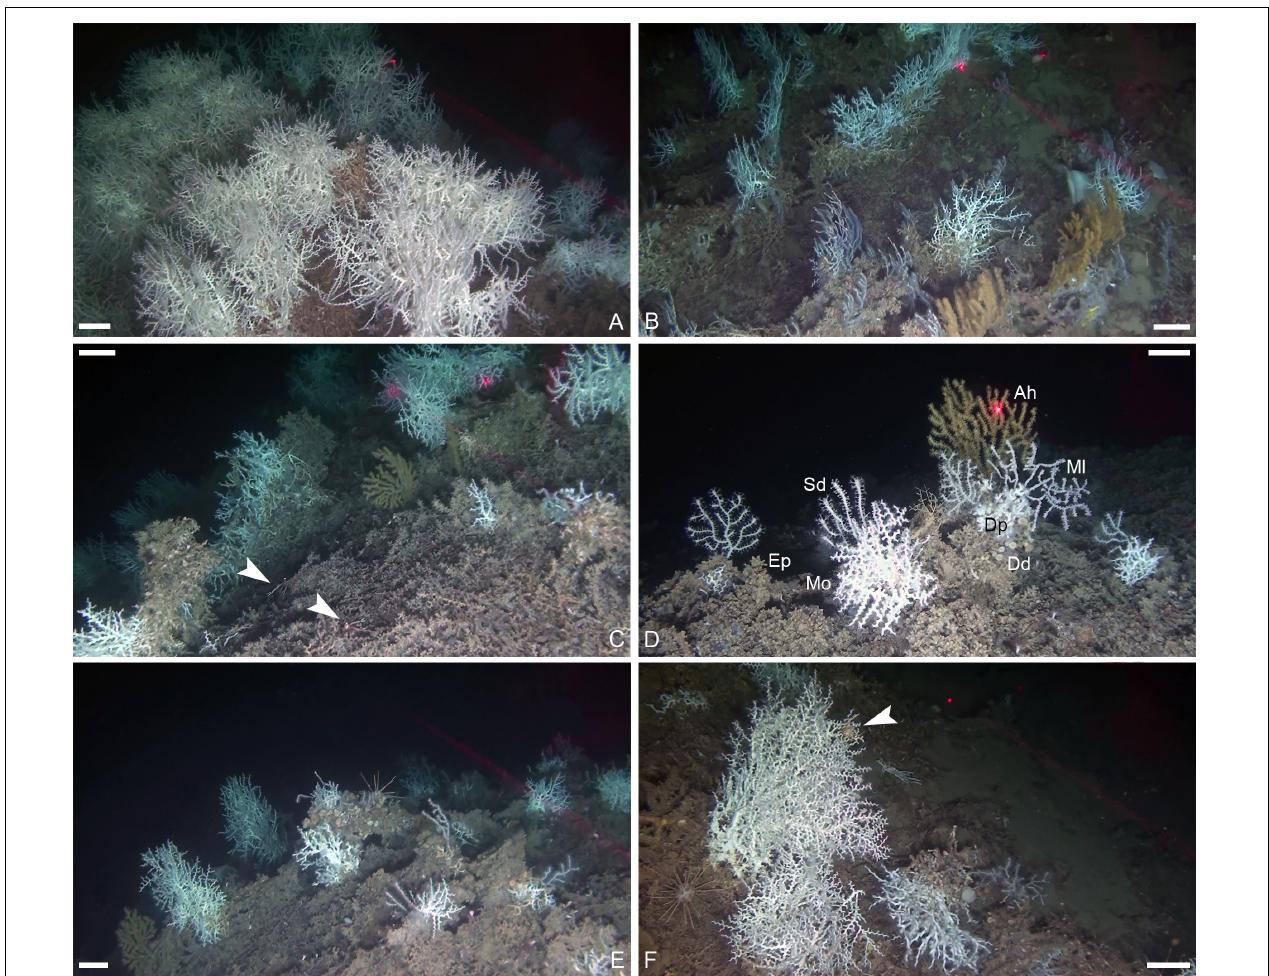
FIGURE 4 | Corsica Channel coral mounds: (A) spatially closed live Madrepora oculata bushes on mound crest (Site A), bar = 20 cm; (B) cnidarian aggregation at mound crest (Site B) showing preferred growth orientation, bar = 10 cm; (C) dense M. oculata growth on dead coral frames at the mound flank, white arrows indicate specimens of Munida tenuimana sheltering on frames, bar = 10 cm; (D) cnidarian aggregation characterized by M. oculata (Mo), Desmophyllum pertusum (Dp), cluster of Desmophyllum dianthus (Dd), Swiftia dubia (Sd), Acanthogorgia hirsuta (Ah), Muriceides lepida (MI) and Epizoanthus sp. (Ep), bar = 20 cm; (E) bush-like M. oculata and D. pertusum colonies growing on dead coral frames, bar = 20 cm; (F) M. oculata and D. pertusum colonies on dead frames, white arrow indicate the decapod Anamathia rissoana , bar = 10 cm. Panels (C to F) are all from Site B.